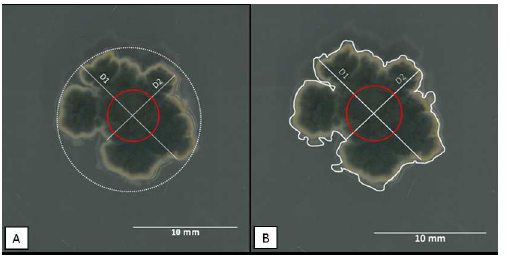
Fig 1. Day 7 growth of Phyllosticta citricarpa on unamended PDA. (A) Measurements D1 andD2 are the perpendicular length for estimating growth and usedto compute calculated area (D A ). The red circle is the approximate placement andsize of the plug. (B) Measuredarea (M A ) is represented by the area encompassed by the whiteoutlineof the colony.